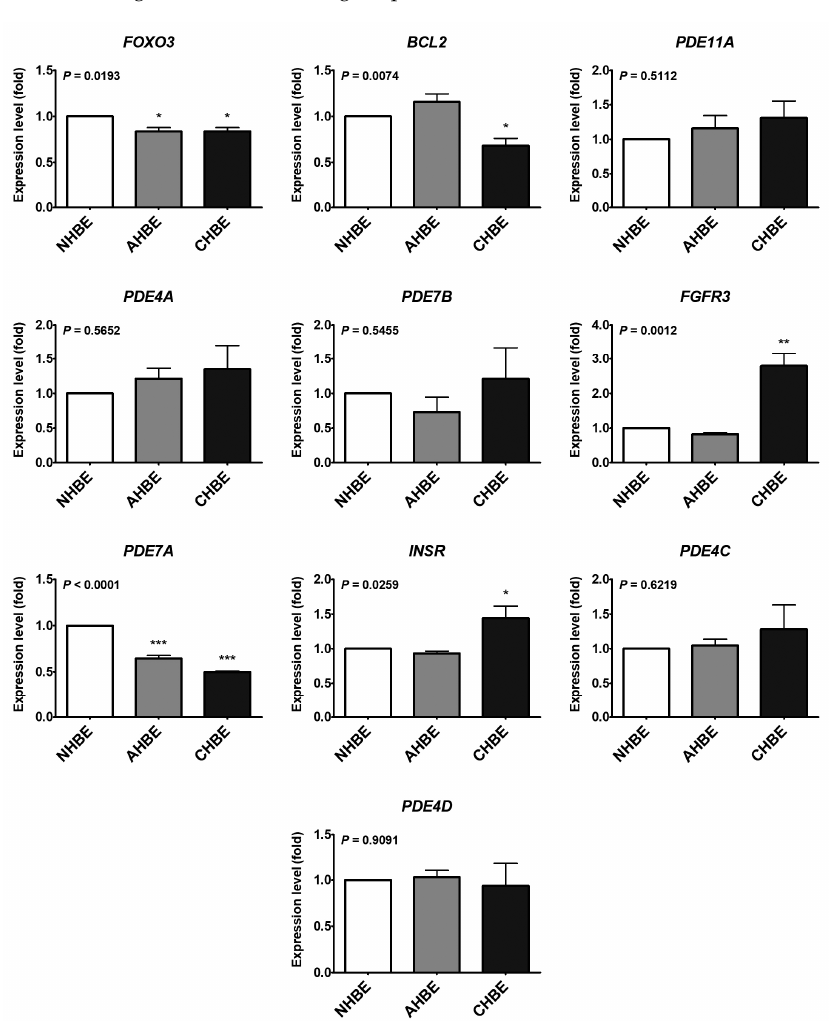
Figure 6. The expression levels of selected genes in primary human bronchial epithelial cells (HBEs) from a normal subject (NHBE), an asthmatic patient (AHBE), and a patient with chronic obstructive pulmonary disease (CHBE). The expression levels of selected genes were assessed with qPCR. Using the 2 − ∆∆ Ct method, the relative mRNA levels in various cells were calculated. All results were expressed as the mean ± standard error of mean of three independent experiments. The expression levels were compared with analysis of variances followed by Dunnett’s test. * p < 0.05, ** p <0.01, *** p < 0.001, as compared with